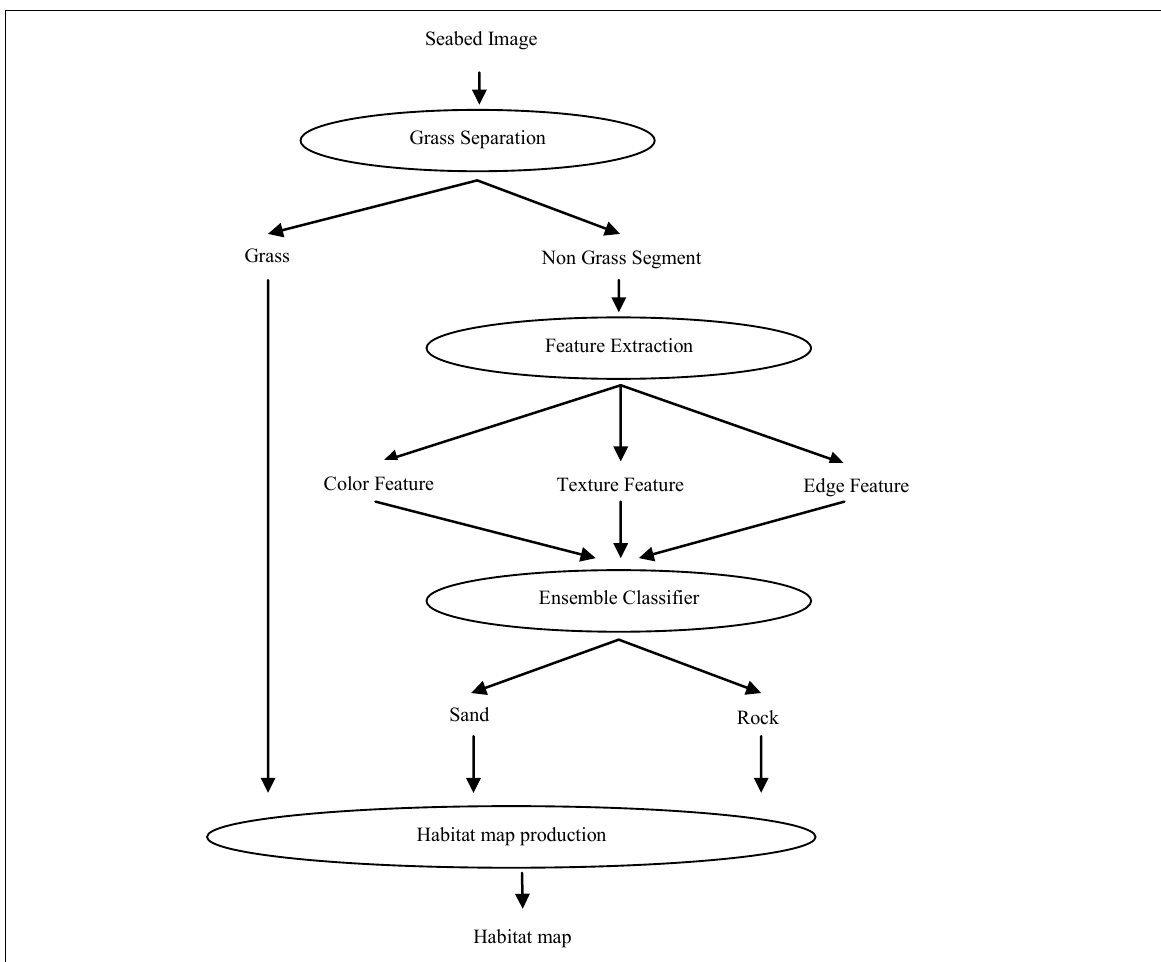
Fig. 1. Habitat map production framework through identification of grass, rock and sand from seabed images using ensemble of color, texture, and edge